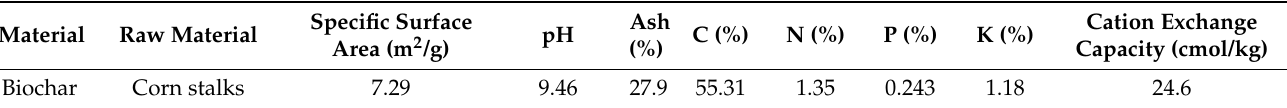
Table 1. Biochar